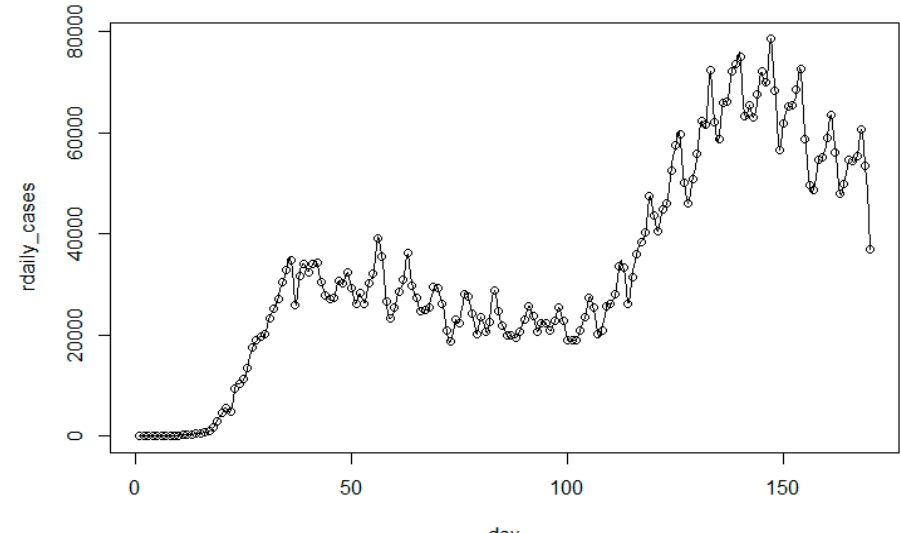
Figure 2. Daily number of deaths over time for the United States.